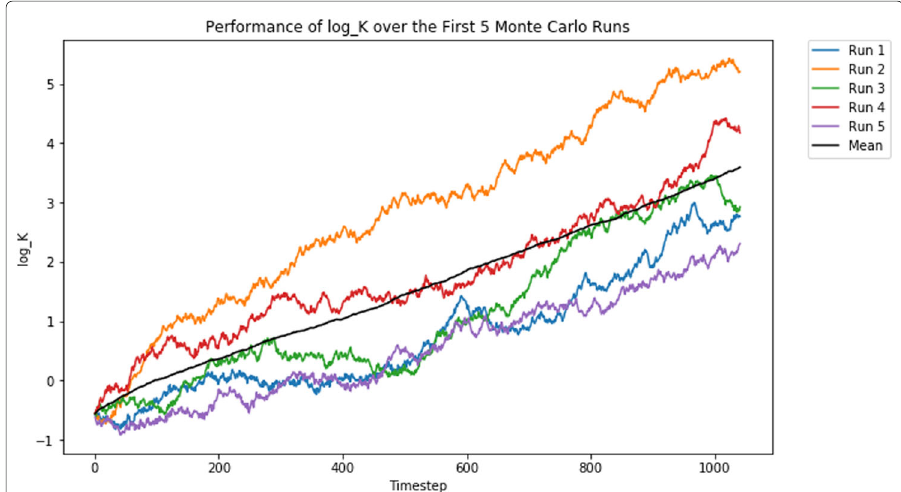
stochastic dynamical systems. These tools and theories are powerful in understanding and designing complex token